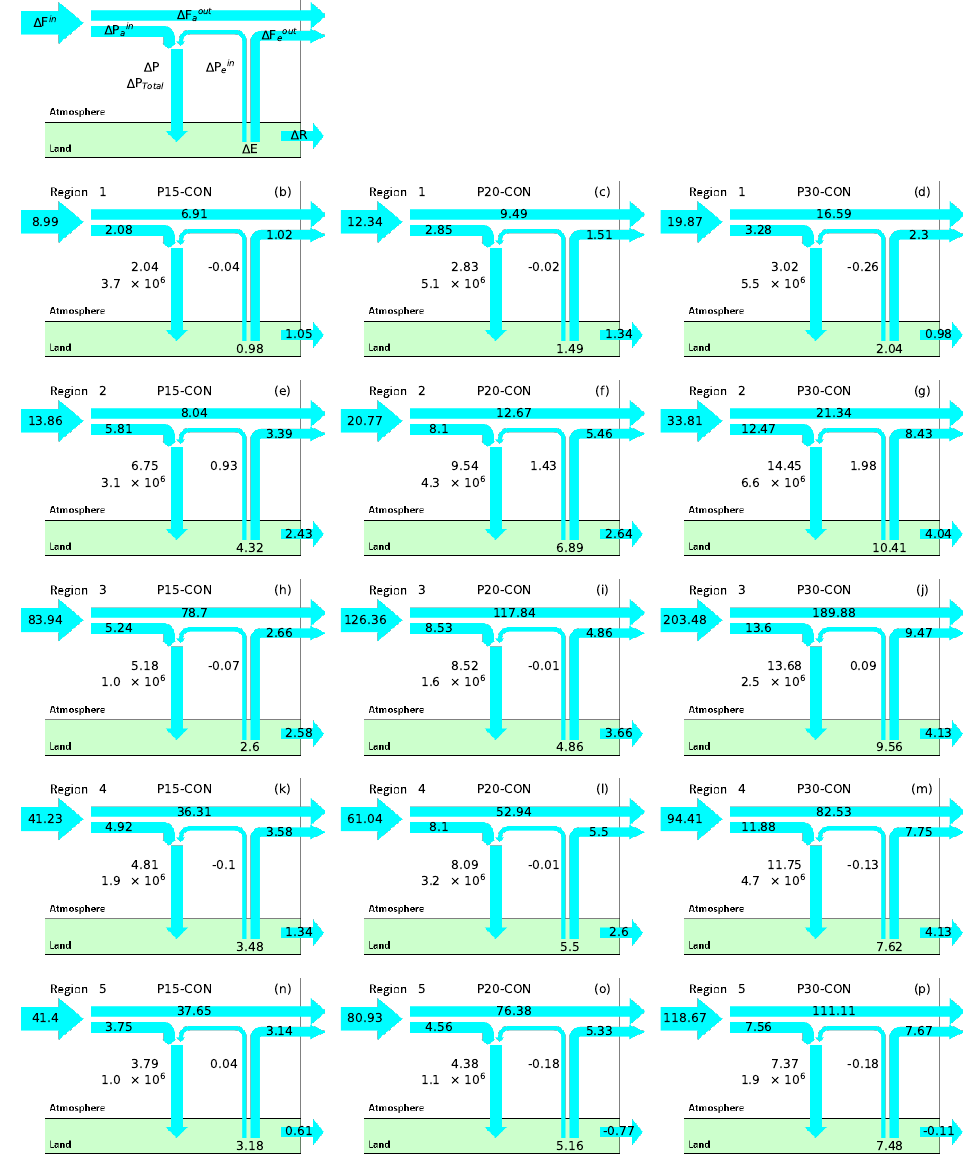
Figure 9. Schematics of the annual-mean differences in the hydrological cycle between future warming scenarios ( b , e , h , k , n ) P15, ( c , f , i , l , o ) P20, ( d , g , j , m , p ) P30 and CON for each of the five regions, ( b – d ) Region 1, ( e – g ) Region 2, ( h – j ) Region 3, ( k – m ) Region 4, ( n – p ) Region 5. ( a ) is the key for the schematic. Arrows denote parts of the hydrological cycle. ∆ F in is the change in horizontal moisture influx; ∆ F out a is the change in outflux of advected moisture; ∆ F out e is the change in outflux of locally evaporated moisture. ∆ P in a is the change in the component of precipitation originating from advected moisture; ∆ P in e is the change in component of precipitation originating due to local evaporation. ∆ P and ∆ E are the changes in precipitation and evaporation respectively represented as a percentage and the precipitation change is shown as ∆ P Total . ∆ R represents the change in surface runoff, calculated as a residual between precipitation and evaporation. The differences in the moisture budget terms are expressed as percentages of CON precipitation for that region. ∆ P Total (kg s − 1 ) is not normalized by the CON